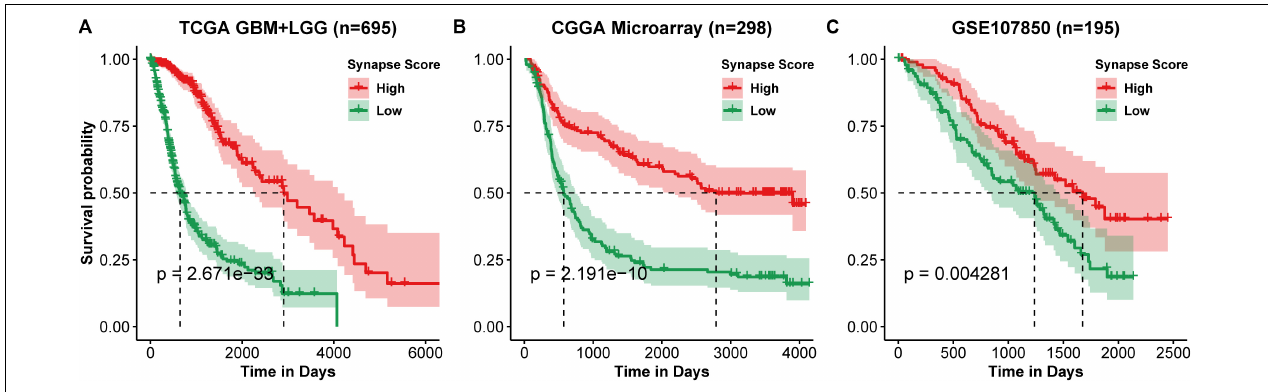
FIGURE 2 | Kaplan–Meier curve of overall survival. (A) TCGA lower grade glioma (LGG) and glioblastoma multiforme (GBM). (B) CGGA Microarray. (C) GSE107850 from GEO datasets. Group was separated by the median value of synapse scores. Differences between two curves were estimated by log-rank test.